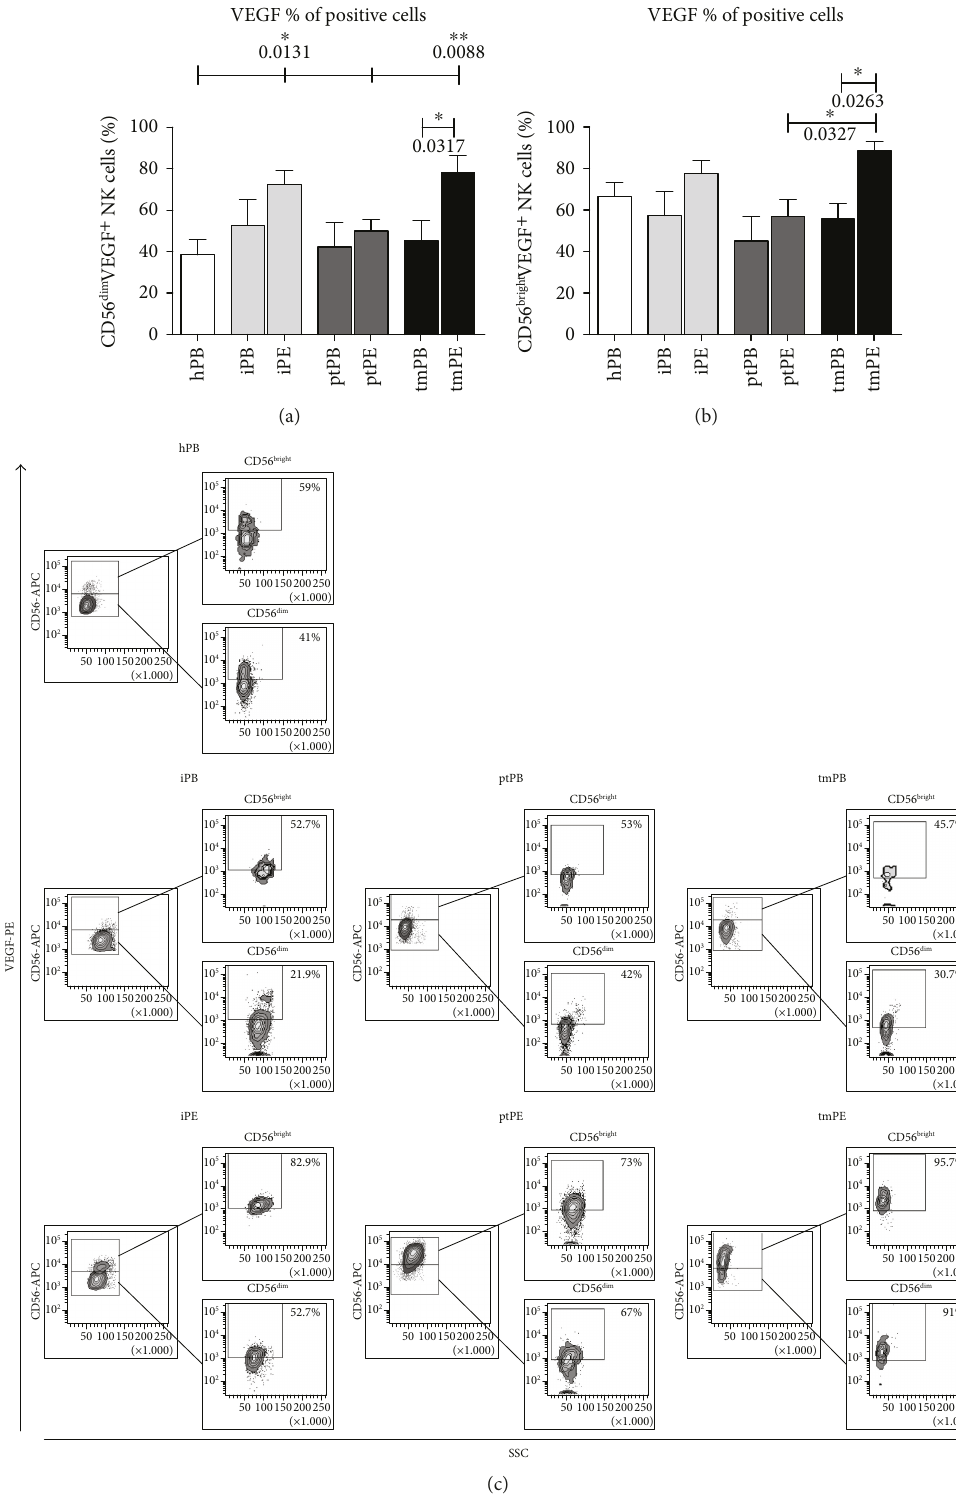
Figure 7: VEGF production by NK cell subsets. Flow cytometric analysis on CD56 bright and CD56 dim NK cell subsets from healthy individuals (hPB), peripheral blood (iPB) and pleural e ff usion (iPE) from patients with in fl ammatory disease, peripheral blood (ptPB) and pleural e ff usion (ptPE) from patients with primary tumor, and peripheral blood (tmPB) and pleural e ff usion (tmPE) from patients with tumor metastasis revealed an increased production of VEGF in PE samples as compared with PB and healthy donors (a-b). Representative dot plots of VEGF production by CD56 bright and CD56 dim NK cell subsets from healthy donors and patients with in fl ammatory, primary, and metastatic tumor PE are shown, respectively (b). Data are shown as mean ± SEM of 34 samples; ∗ p < 0 05 and ∗∗ p < 0 01 ( p values are